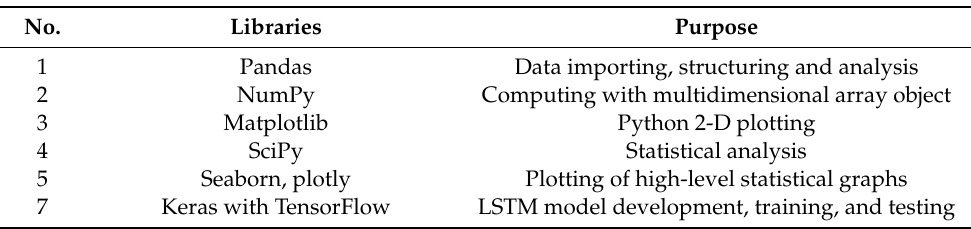
Table 4. Python libraries for data processing [61].